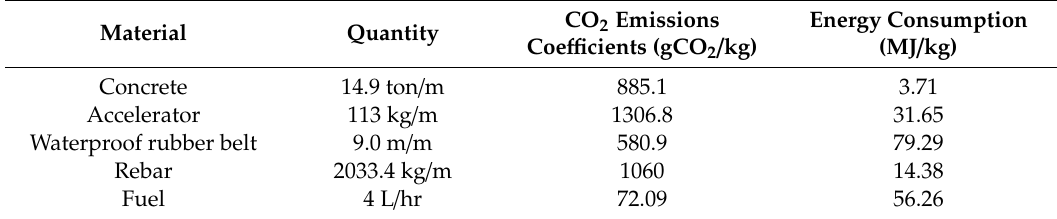
Table 6. Material characteristics for tunnel construction.